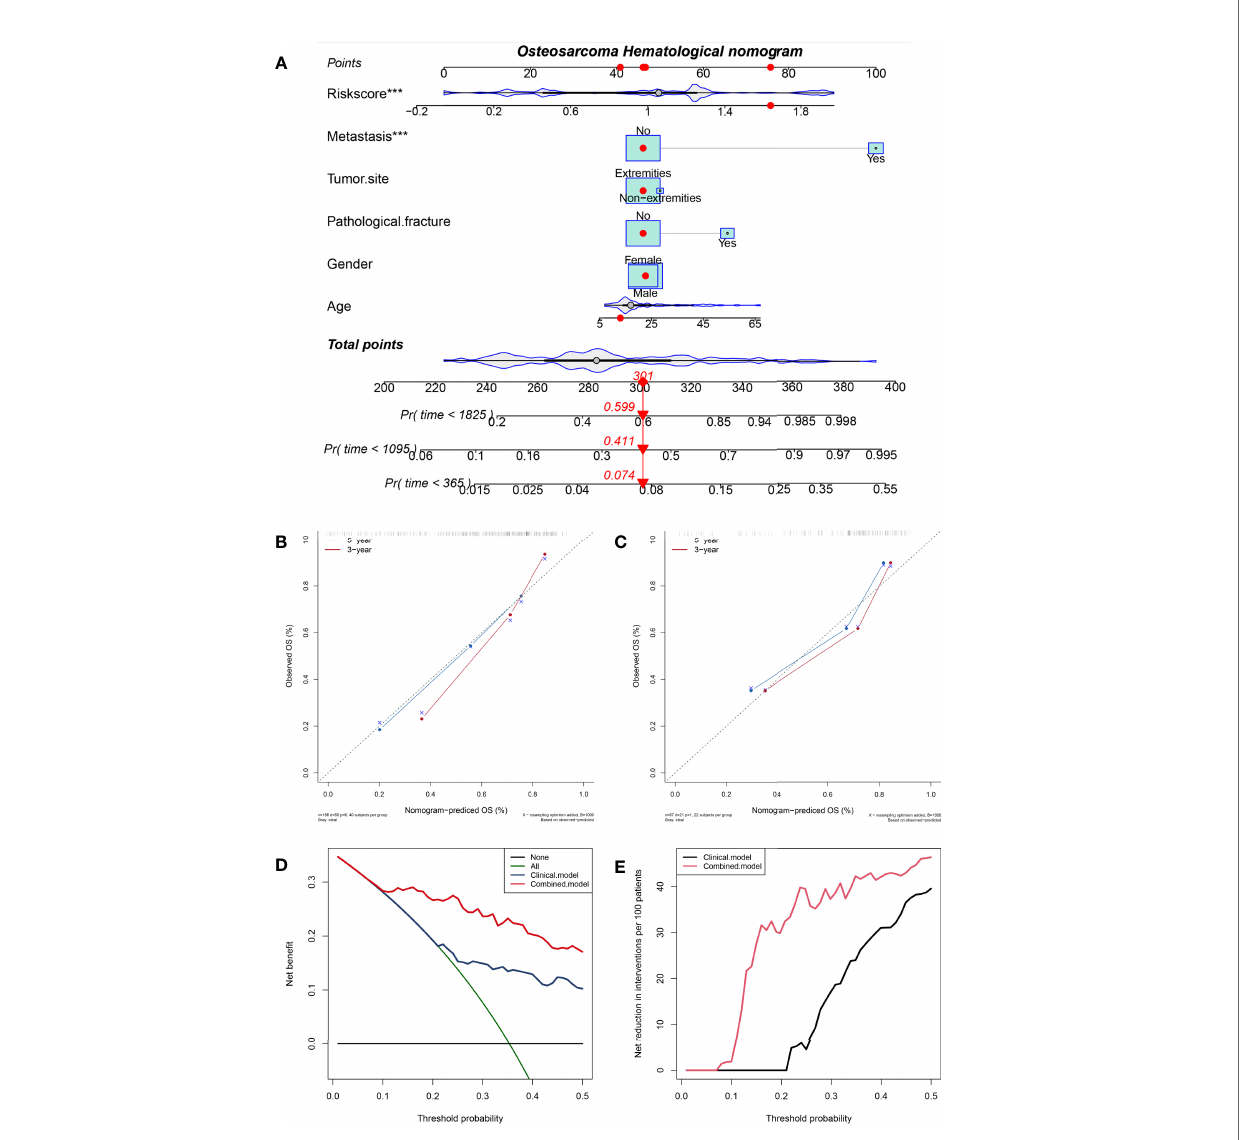
FIGURE 4 | A nomogram was constructed combining HPSS with clinical features and the predictive power of the nomogram was assessed. (A) The nomogram of the overall survival of patients with osteosarcoma shows that HPSS score and tumor metastasis status are the two most important variables; (B) Calibration curves for nomogram predicting 3-year and 5-year survival of patients in the training set; (C) Calibration curves for nomogram predicting 3-year and 5-year survival of patients in the validation set; (D) The clinical net bene fi t curve of the nomogram; (E) Clinical Net Reduction Curve for Nomogram. ***p <